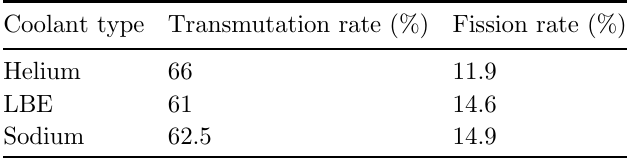
Table 5. Effect of the coolant material type for a cell with 6.5% Am, averaged over the results for the four fuel